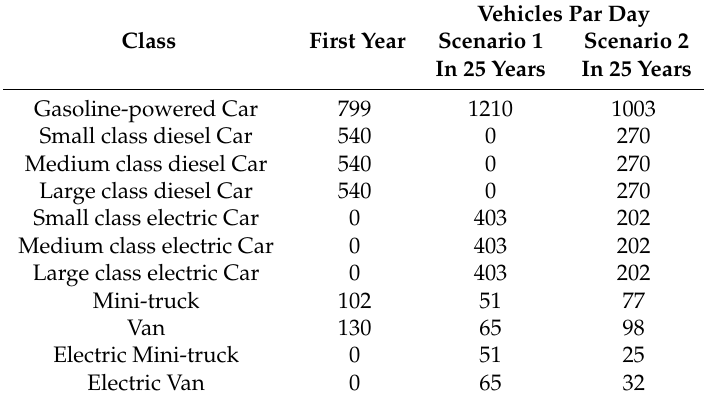
Table 8. Vehicle number in scenarios 1 and 2.